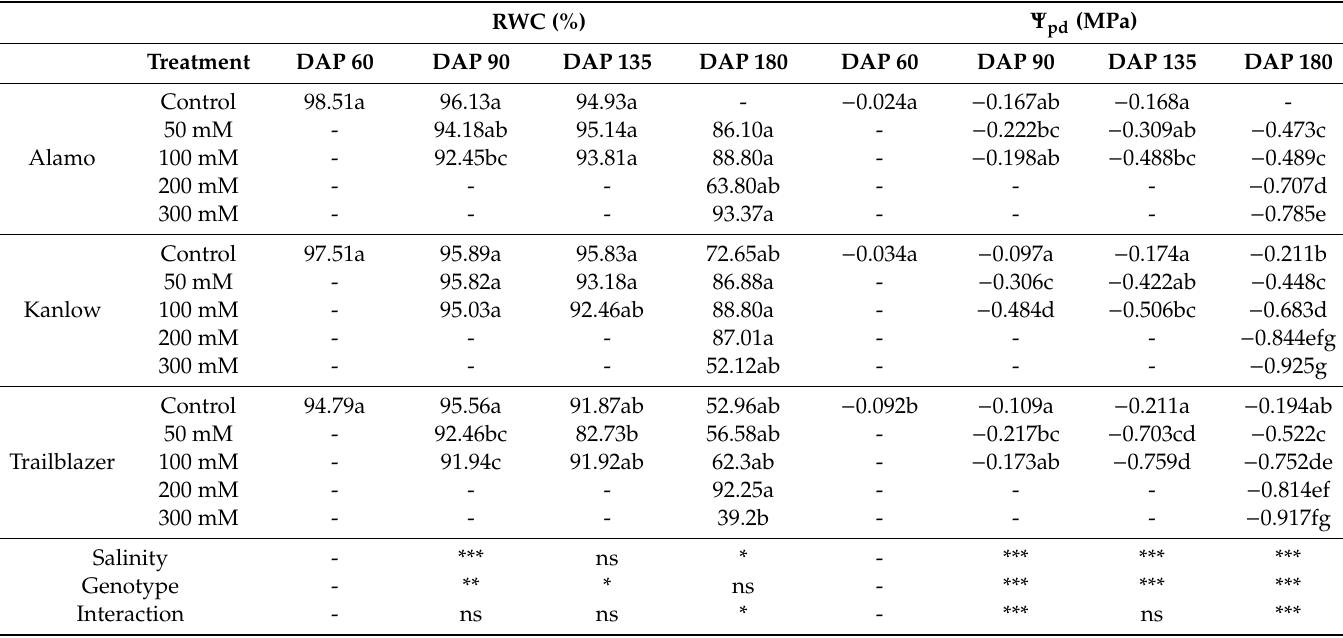
Table 4. The leaf relative water content (RWC) and pre-dawn leaf water potential ( Ψ pd ) for the control, 50, 100, 200 and 300 mM NaCl treatments for Alamo, Kanlow and Trailblazer genotypes of Panicum